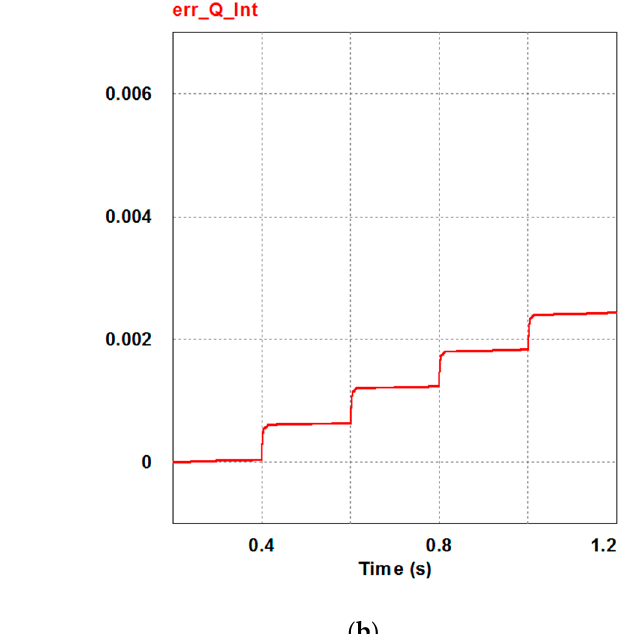
( b ) Figure 21. Detailed views of Figure 20a: ( a ) from 0.3 to 0.5 s; ( b ) from 0.5 to 0.7 s. 5. Hardware Prototype Implementation In order to verify the simulated results of the proposed GaN HEMTs-based STAT- COM system and the control schemes, this section presents the hardware implementation